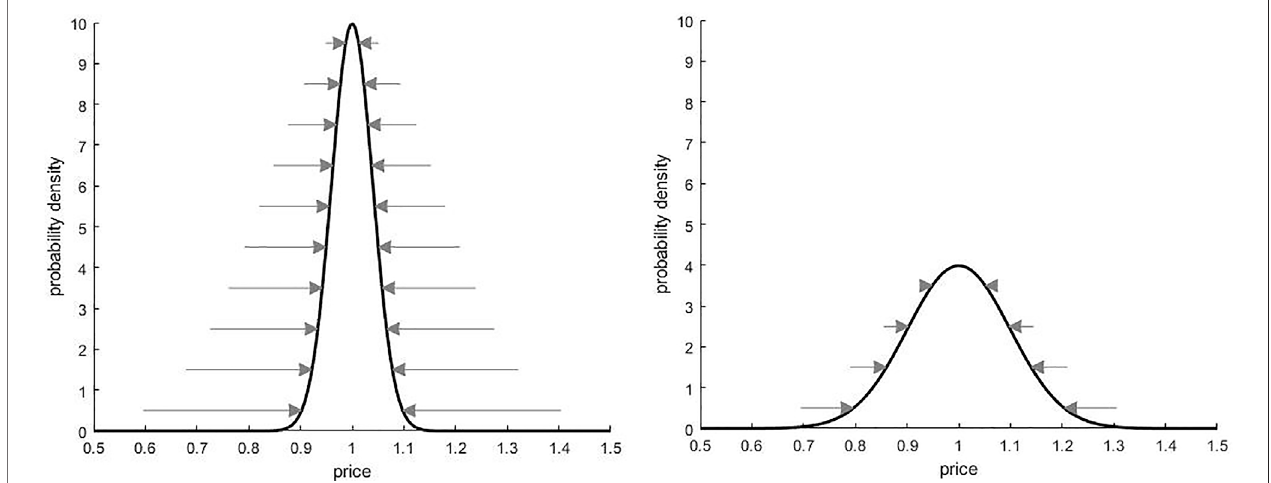
FIGURE4| Thecurvesshowpropensityasafunctionofprice,measuredinmillionsofdollars.Botharecenteredat p (cid:2) 1,butthepanelontherighthasahigherlevel of price fl exibility. The arrows indicate the strength and direction of the associated entropic forces (discussed later).